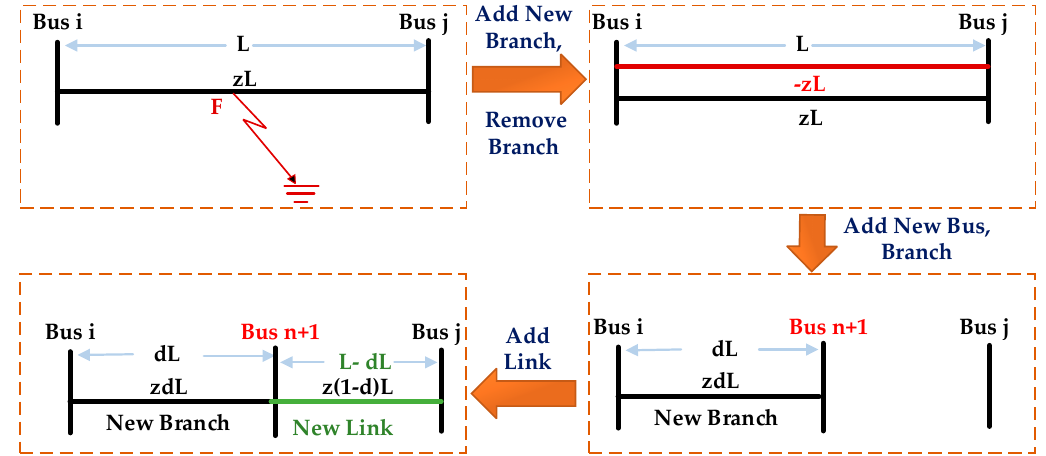
Figure 2. Z Bus modification procedure for adding a virtual bus.